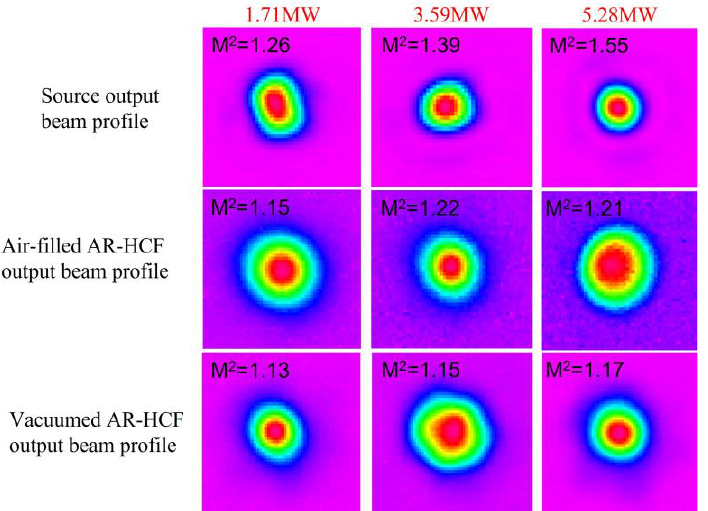
Figure 7. Beam profiles and corresponding M 2 factors of the incident laser beam and output at the end of air-filled and vacuumed AR-HCF at input power of 1.71 MW, 3.59 MW, and 5.28 MW.